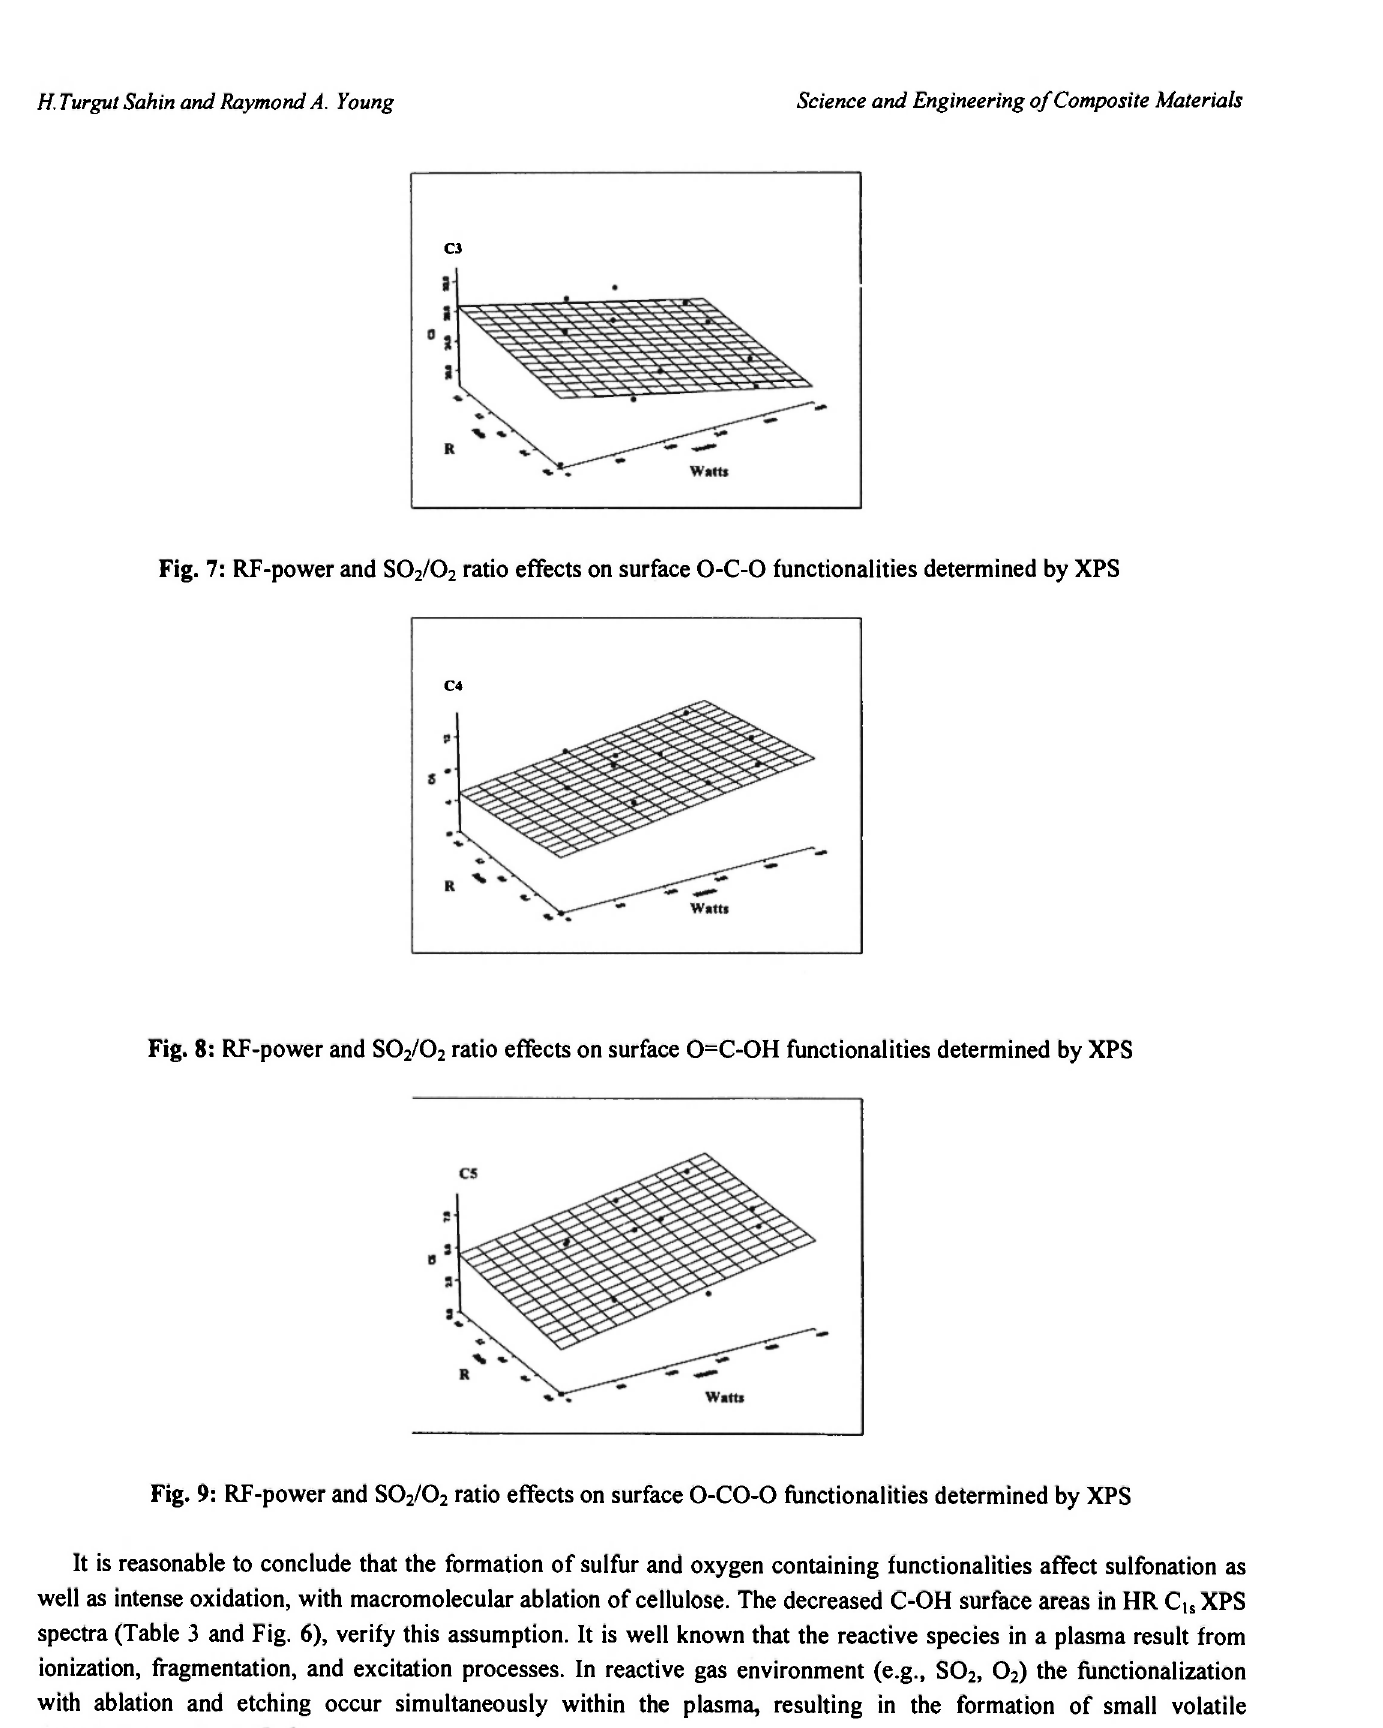
Fig. 7: RF-power and SO2/O2 ratio effects on surface O-C-O functionalities determined by XPS